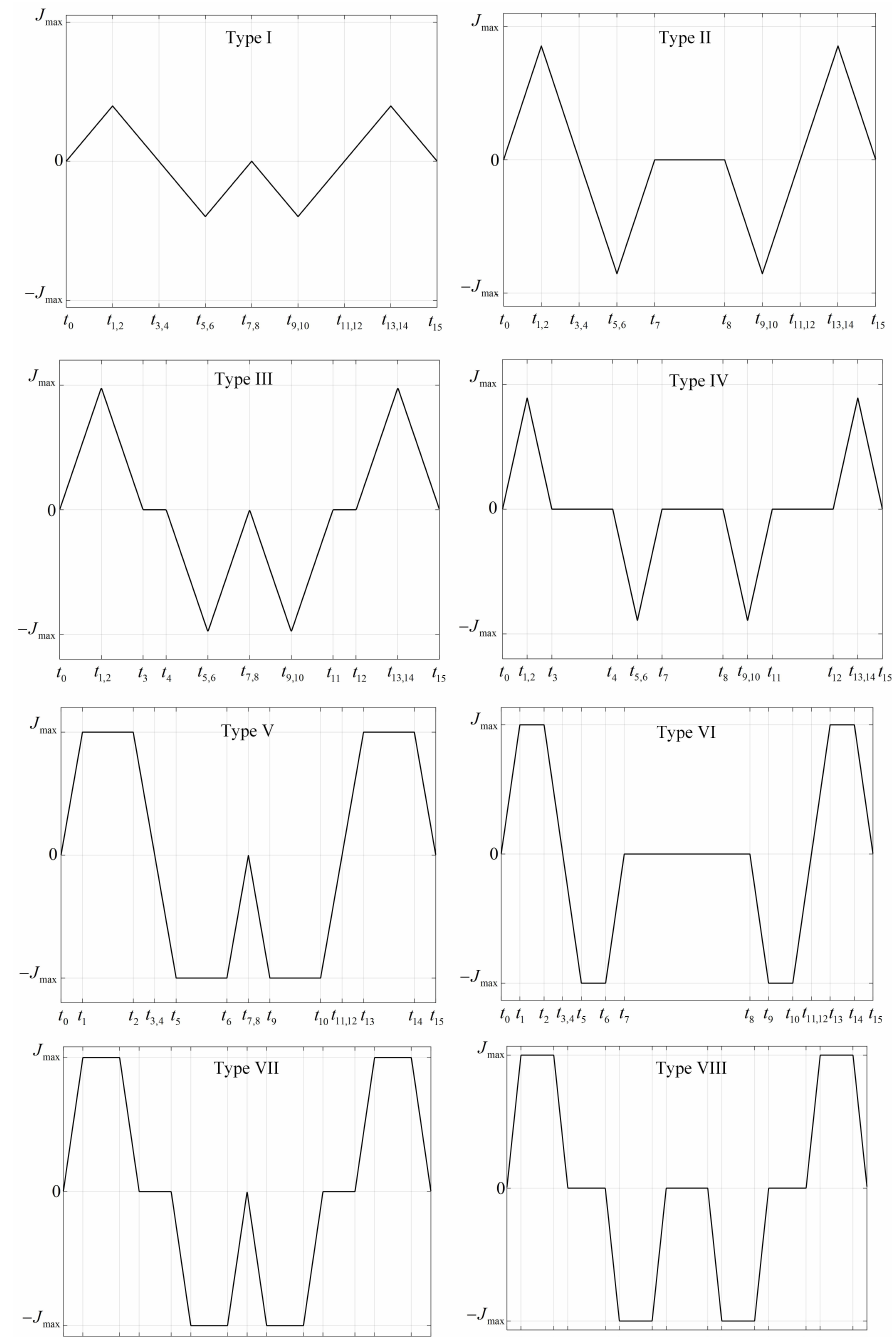
Figure 4. Different motion profiles when planning an S-curve